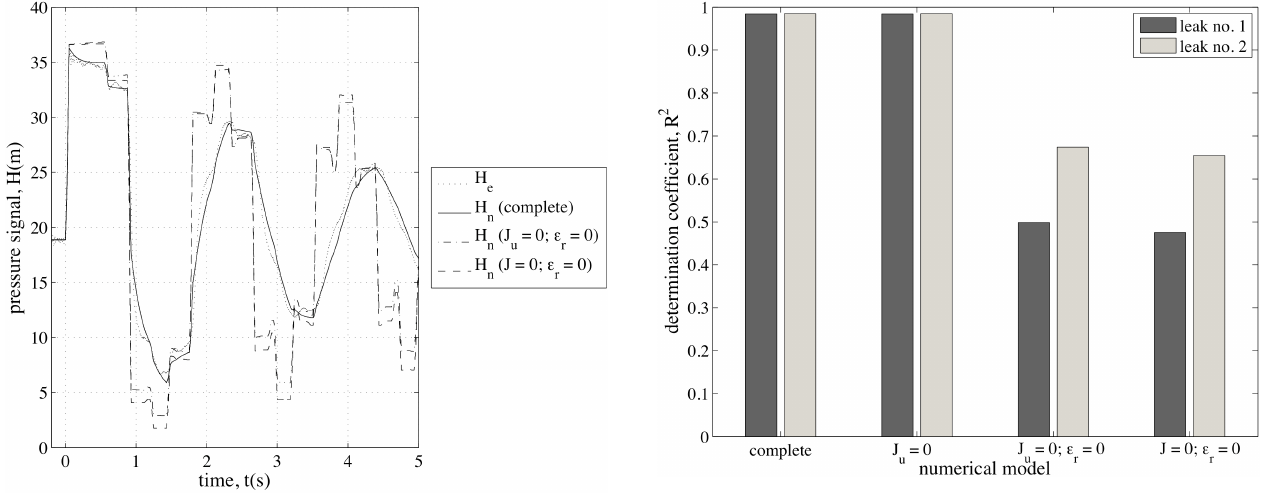
Figure 8. Damaged pipe with leak no. 2 ( Q 0 = 3.15 l/s): experimental pressure signal at section M vs. numerical model simulations.